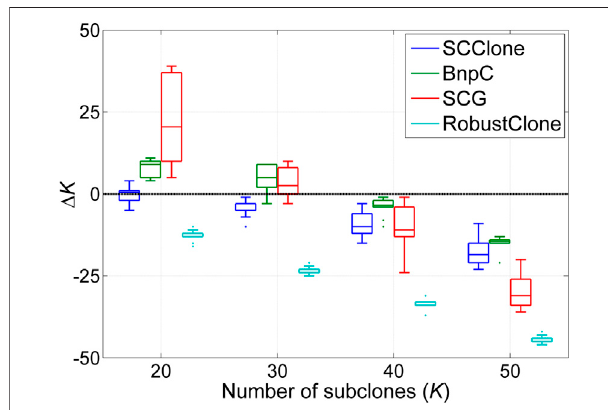
FIGURE6| PerformanceevaluationresultsonthesimulateddatasetD6. The dataset consists of 200 × 50 genotype matrices with fi ve subclones.